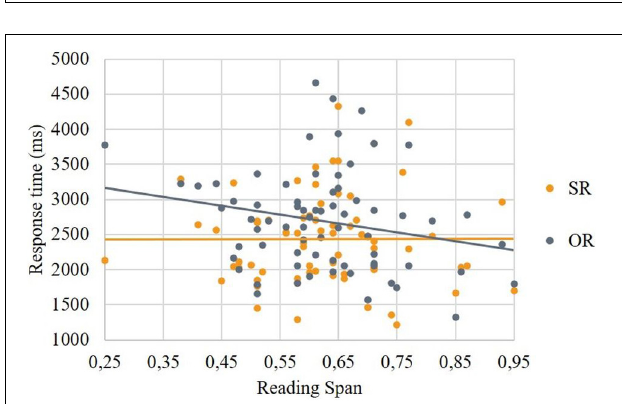
FIGURE 5 | Correlation between Reading Span and response time in relative clause